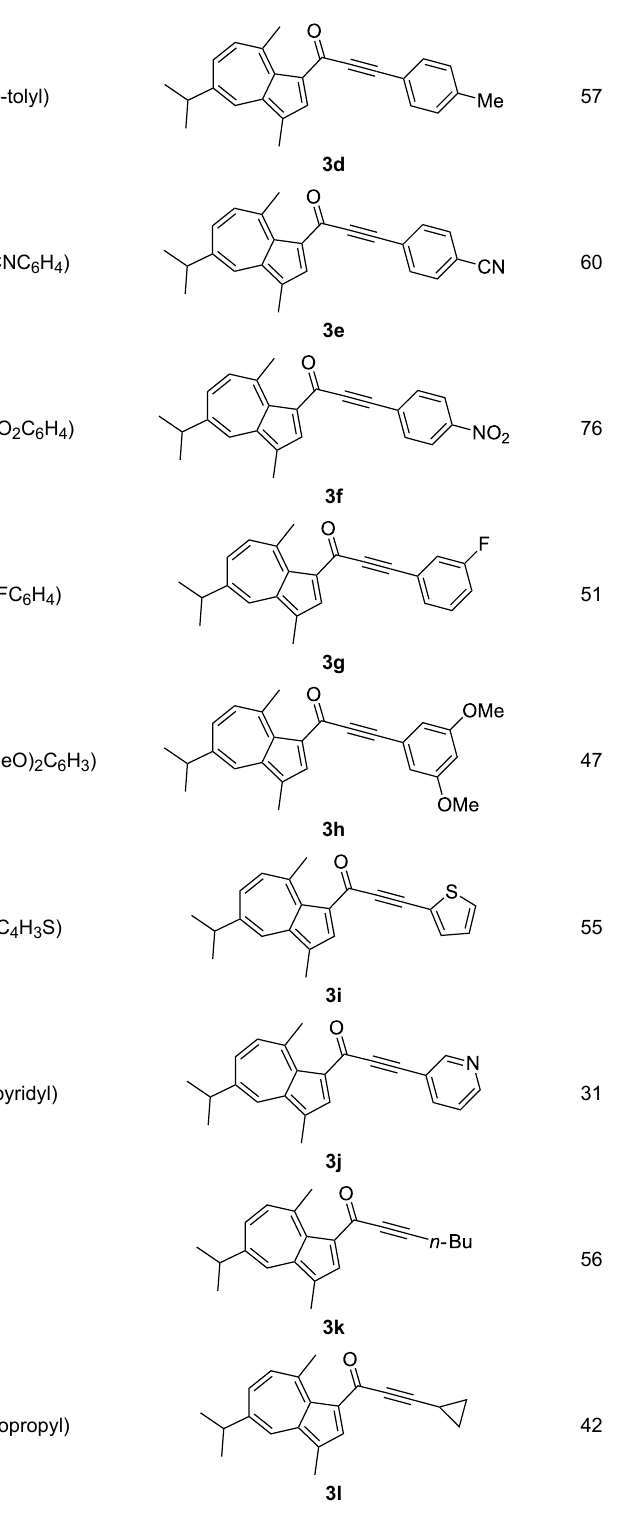
Table 2: Three-component synthesis of azulenyl- and guaiazulenylynones 3 . a